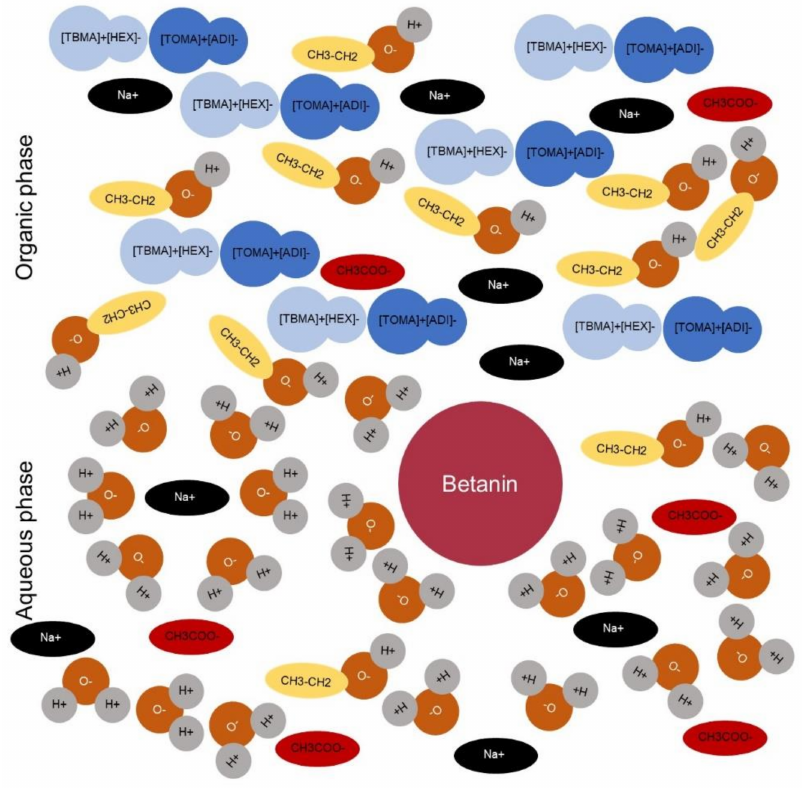
Figure 6. Formation of two phases during the desorption process using the kosmotropic